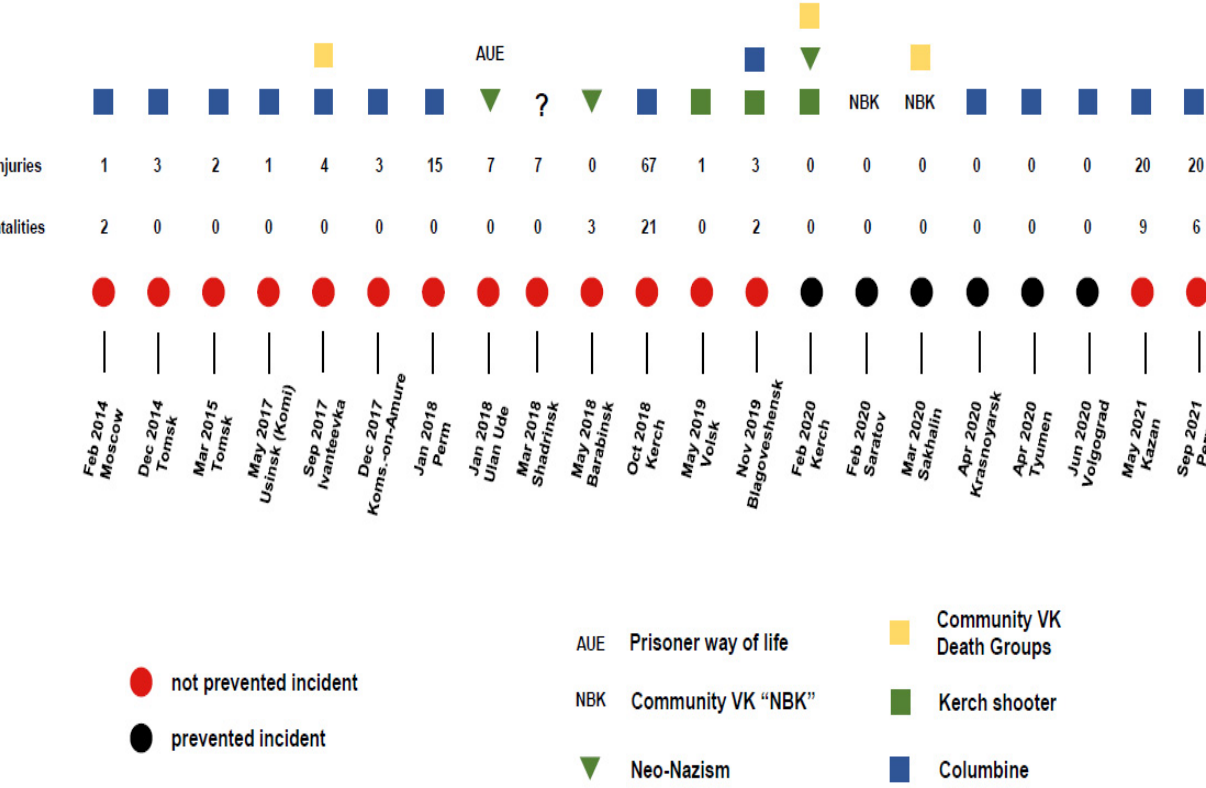
Figure A1. 21 cases of school shooting in Russia: general scheme.